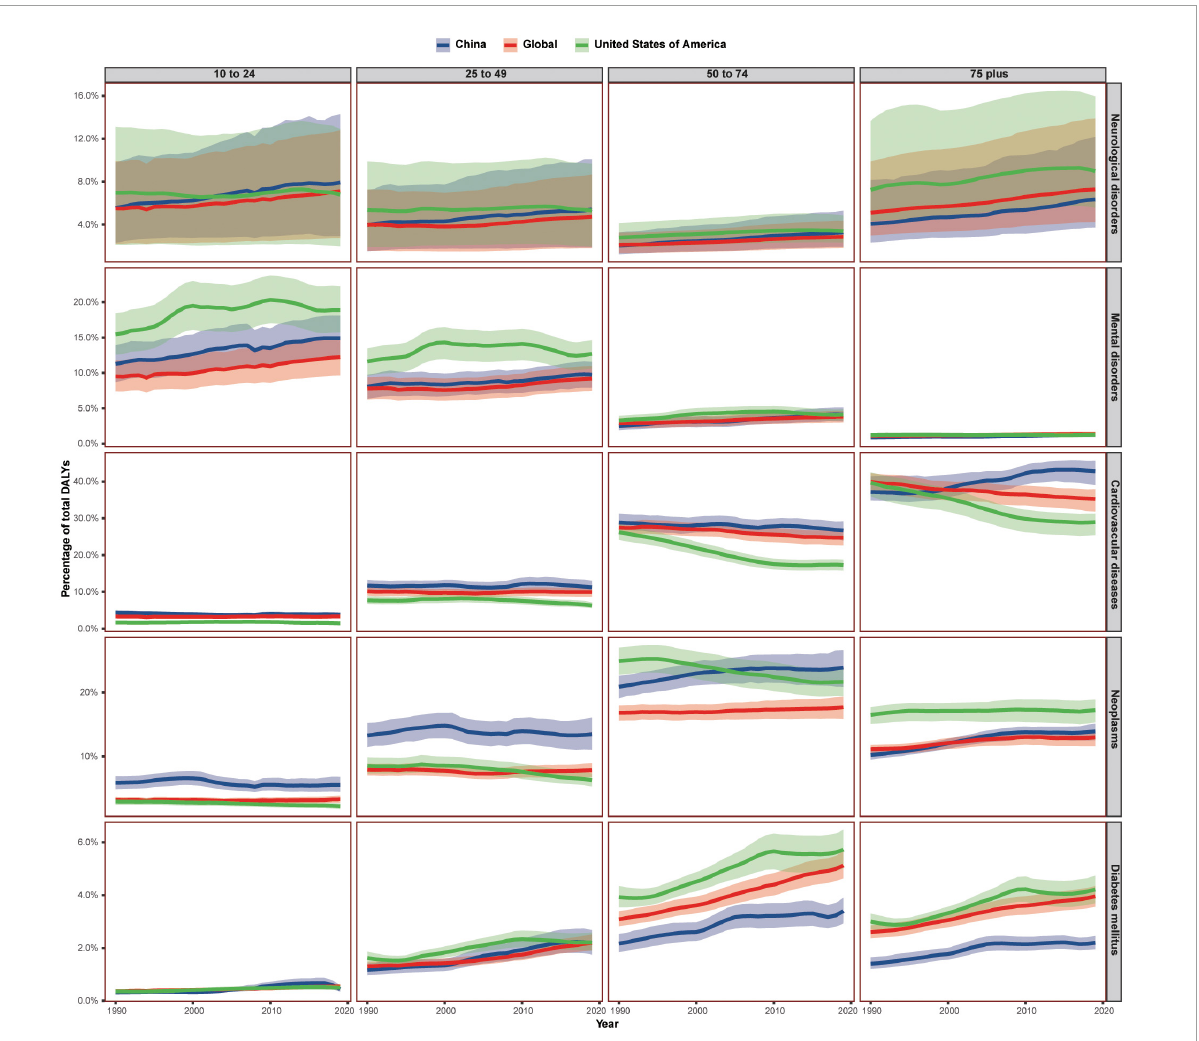
FIGURE2 The burden trend of neurological disorders, mental disorders, and three major physiological diseases in China, the United States of America, and the world, by age group. Shaded sections indicate 95% uncertainty intervals. DALYs, disability-adjusted life-years.